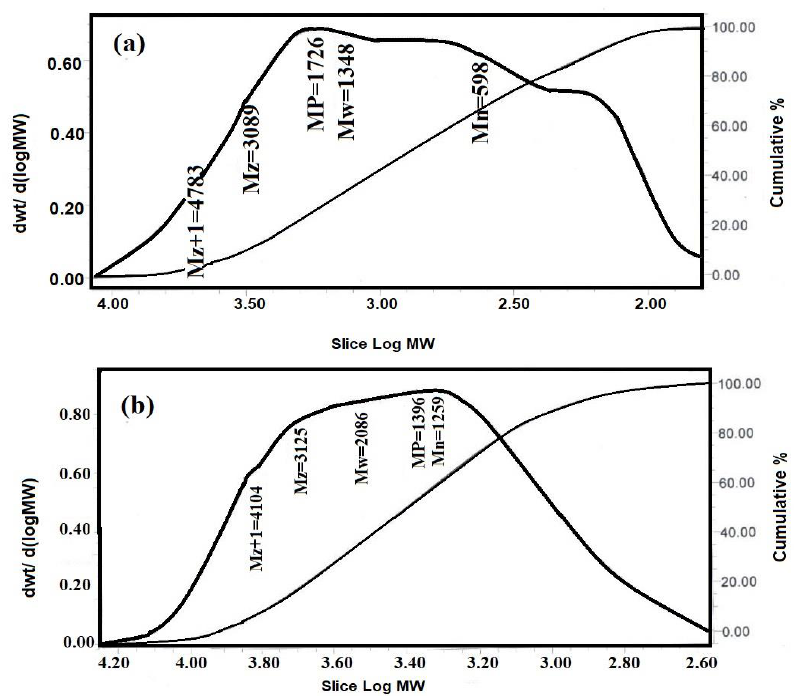
Scheme 1. Aminolysis of PET waste to APA and PAIIL. Coatings 2020 , 10 , x FOR PEER REVIEW